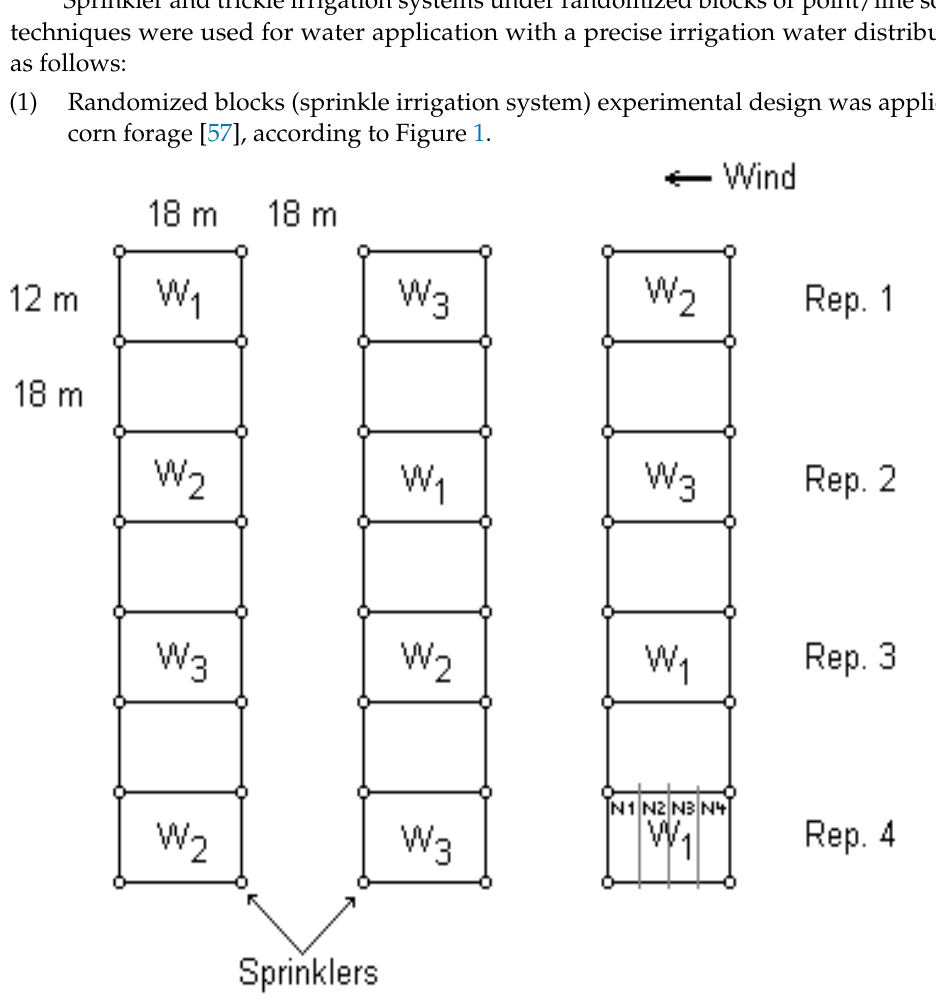
Figure 1. Schematic representation of the randomized blocks experiments. The plots marked by W 1 to W 3 denote three sprinkler irrigation levels. Each plot marked by W is divided at random into four subplots of salt treatments (N1, N2, N3, N4). Number of replications are